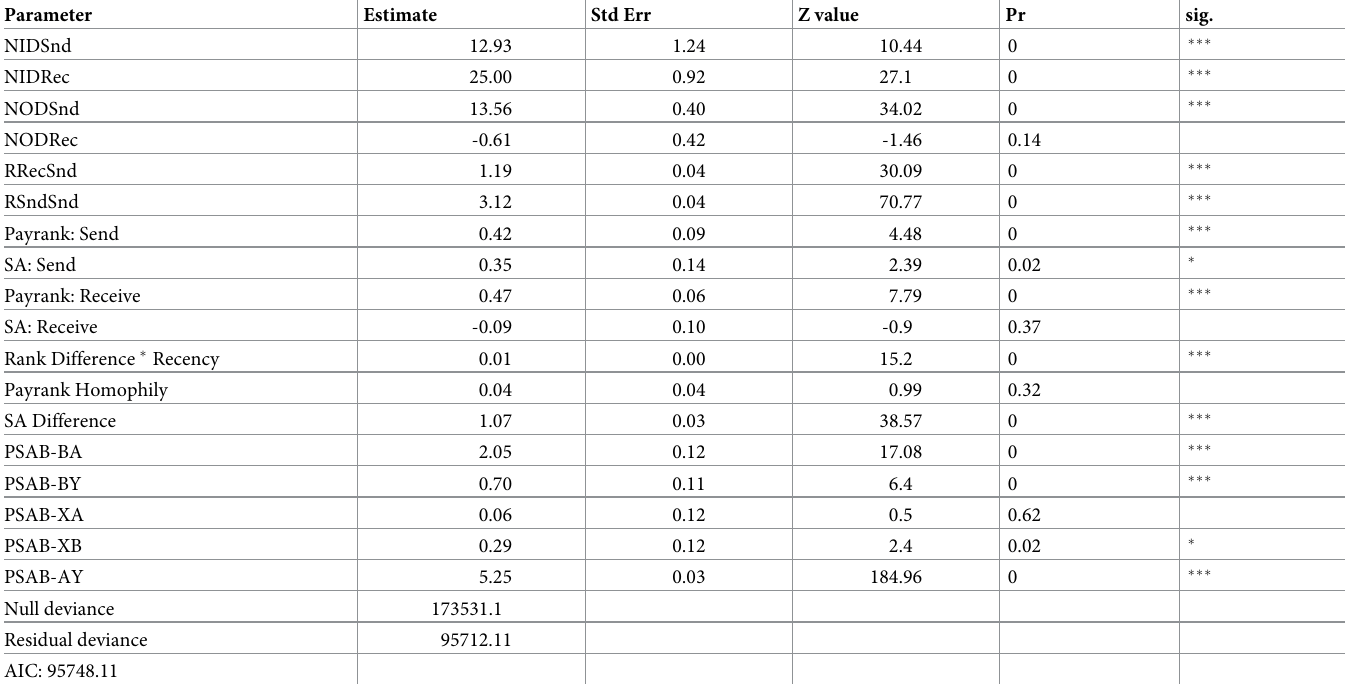
Table 2. Relational events model of an email network among a command-and-control military exercise. Signif. codes: p < 0 ��� ; p < 0.001 �� ; p < 0.01 �